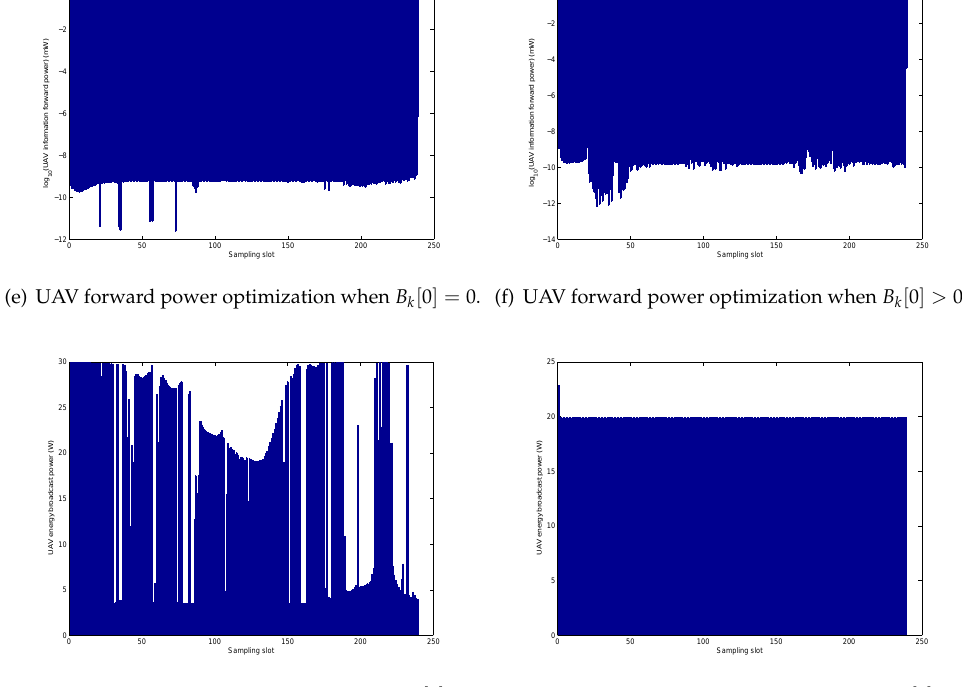
Figure 12. Optimization results of B k [ 0 ] = 0 and B k [ 0 ] > 0 when T = 240